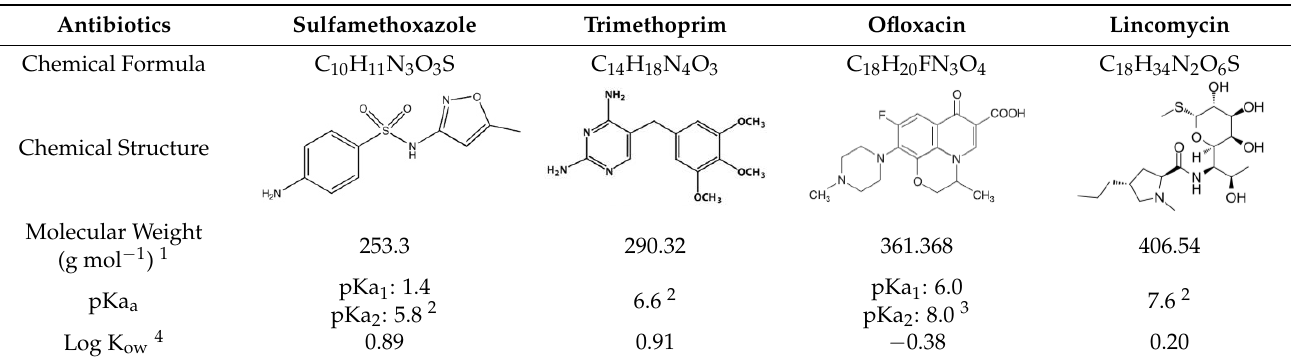
Figure 1. General analytical steps that water and soil samples underwent during this study to determine optimal extraction techniques to determine concentrations of four antibiotics (sulfamethoxazole, trimethoprim, ofloxacin, and lincomycin (SPE—Solid Phase Extraction, LC/MS-MS—Liquid Chromatography and tandem mass spectrometry). Table 1. Characteristics of the four antibiotics (sulfamethoxazole, trimethoprim, ofloxacin, and lincomycin) extracted from soil and water.